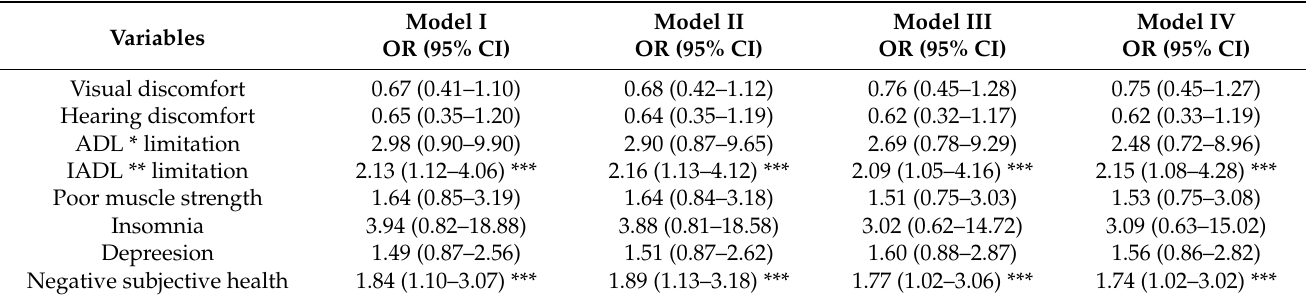
Table 3. Multivariable logistic regression analysis of factors associated with nutritional status in elderly cancer